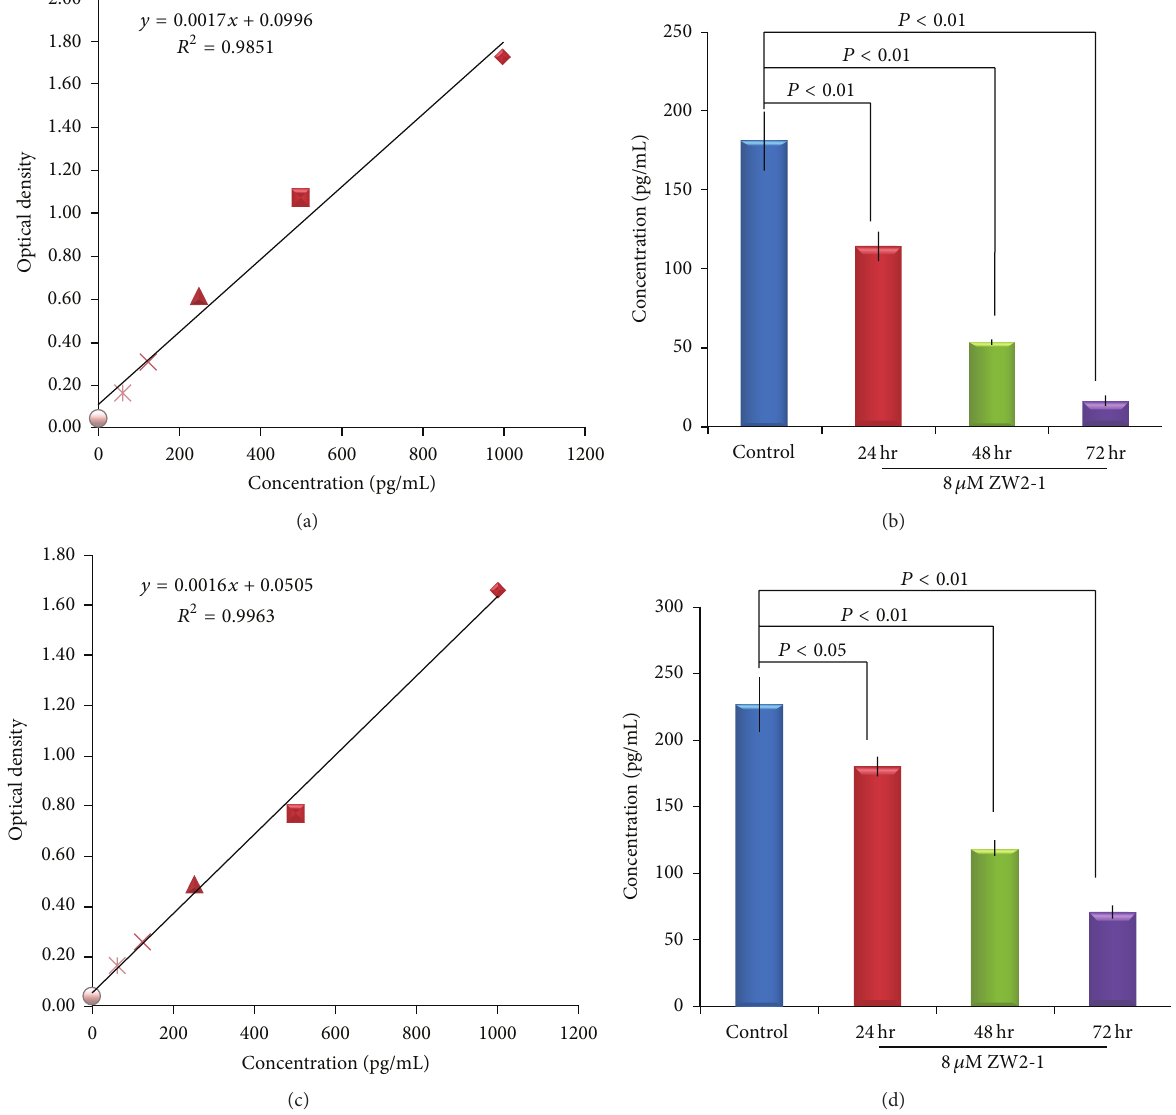
Figure 6: Effects of ZW2-1 on histone acetylation 1 in HL-60 cells. Colorimetric sandwich ELISA assay was used to detect the HDAC1 level in HL-60 and NB4 cells after treatment with ZW2-1 for 0, 24, 48, and 72 h. (a) Standard curve for samples of HL-60 cells. (b) HDAC1 concentrations of HL-60 cells treated with ZW2-1. (c) Standard curve for samples of NB4 cells. (d) HDAC1 concentrations of NB4 cells treated with ZW2-1. Data represents the means of three repeats ±